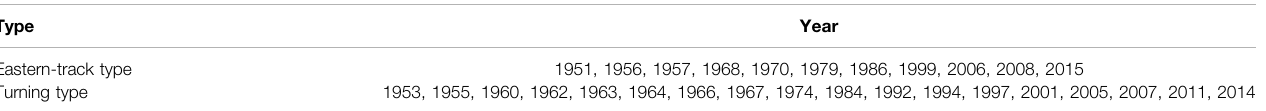
TABLE 1 | List of the years when two types of northward-moving TCs occur